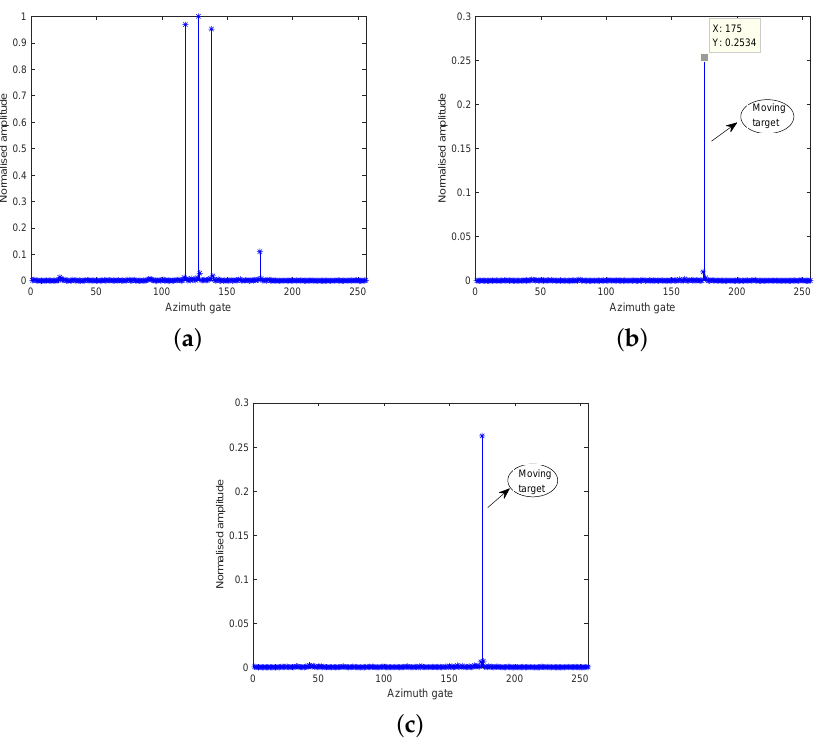
Figure 13. HVB-DCS based reconstruction results with data rate 37.5% in azimuth: ( a ) static scattering centers; ( b ) moving target in channel one; ( c ) moving target in channel two.